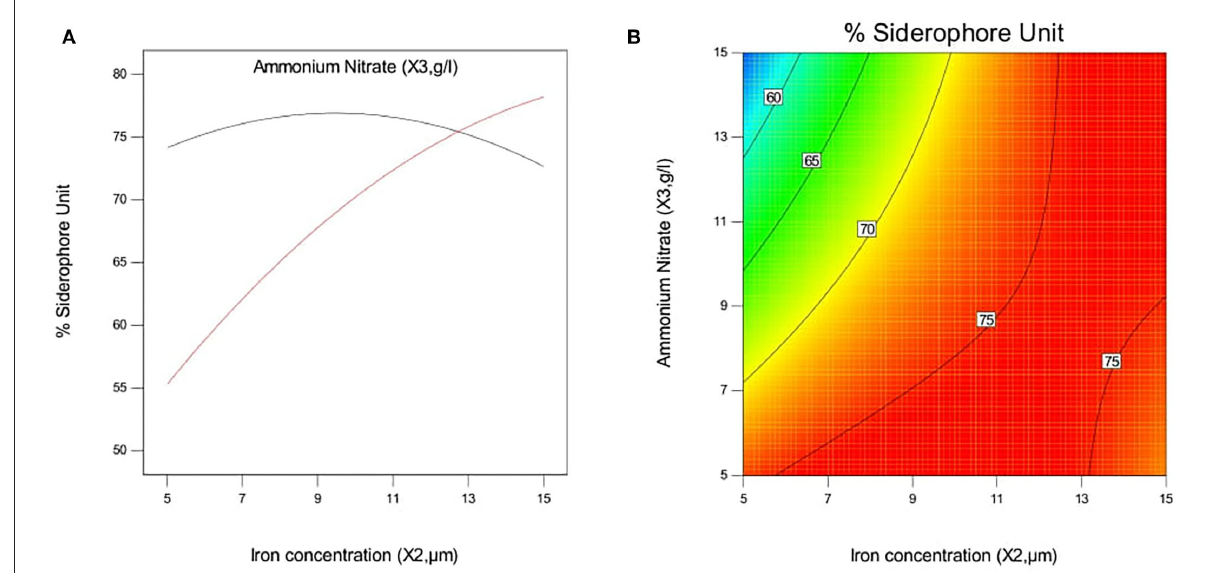
FIGURE6 Effect of iron concentration and ammonium Nitrate concentration on siderophore production in P. monteilli B8 at optimized condition of pH (X1, 7.29). (A) Interactive and (B) contour.